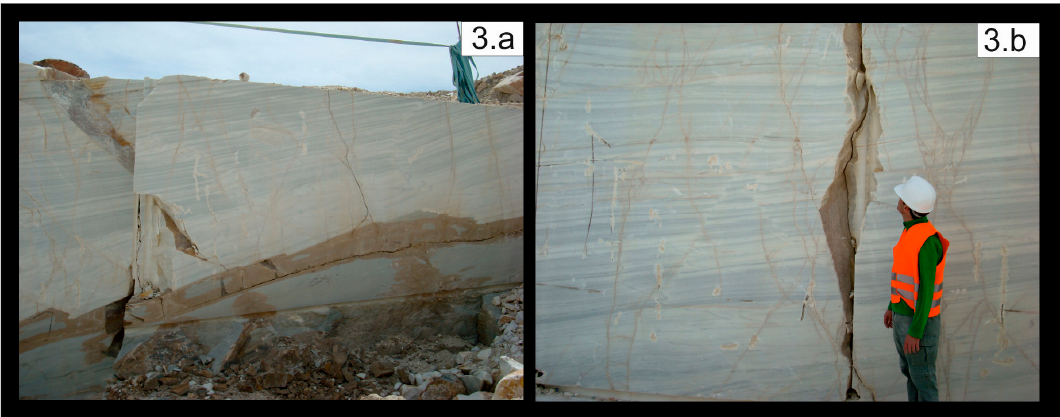
Figure 3. ( a ) Contact of the marble with the micaschist and fracturing; ( b ) Fracture, karstification, and banded marble.